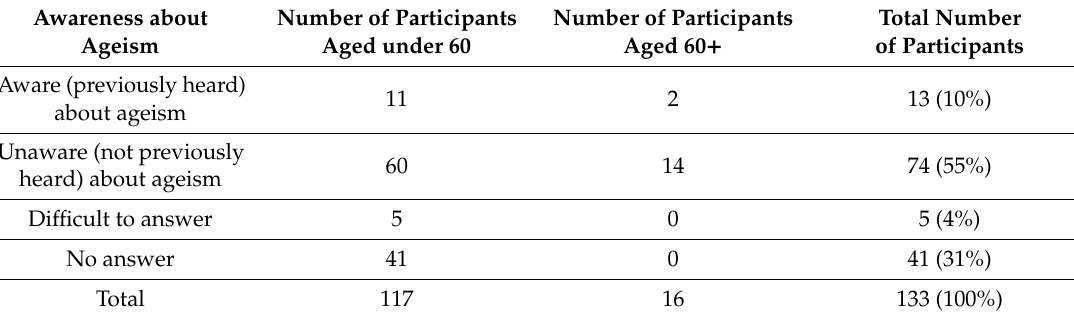
Table 8. Participants’ awareness of